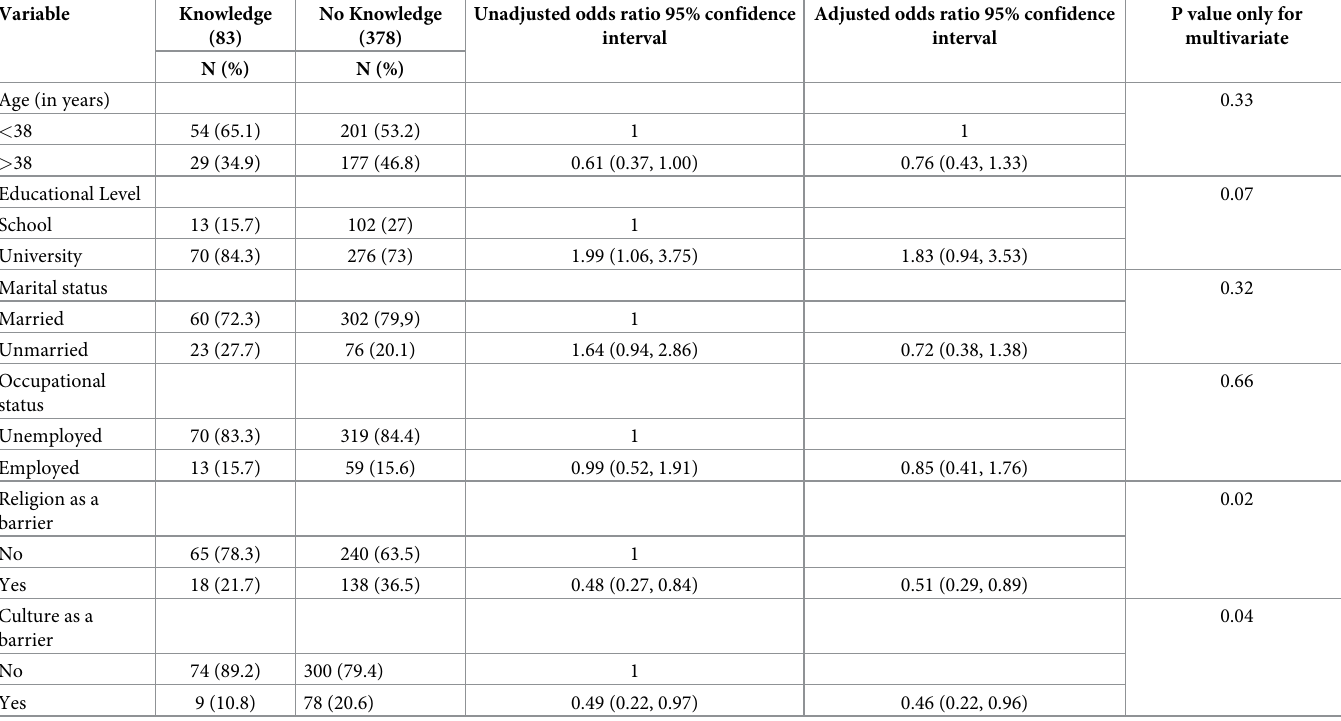
Table 5. Factors affecting the knowledge of ECP among